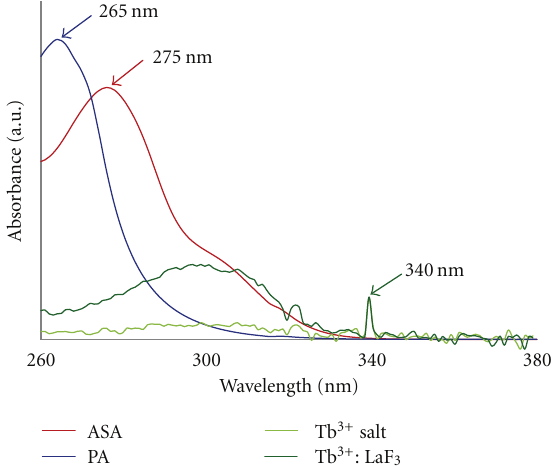
Figure 8: Absoption spectra of PA (blue), ASA (red) ligand, Tb 3+ salt (light green), and Tb 3+ :LaF 3 (dark green) in water.